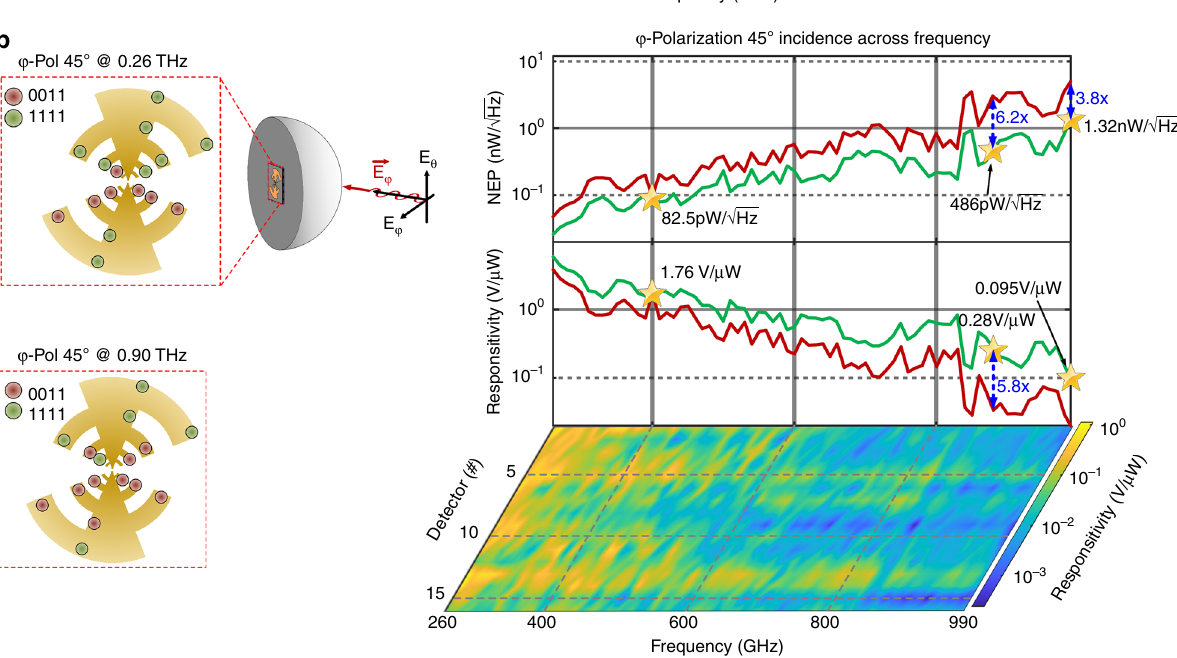
Fig. 7 Measurement results for optimized responsivity and corresponding NEP across 0.1 – 1.0 THz for two incidence angles at a 0° and b 45°, and two polarizations ( E θ and E φ ). The fi gure shows 8.9 and 4.5 times reduction in NEP at 0.86 THz and at 0.99 THz for broadside incidence and 6.2 times reduction in NEP for 45° incidence at 0.87 THz. The green line represents the sensor performance as it is optimized for each incident frequency. The red line represents the performance across frequency for a fi xed optimal con fi guration at 0.4 THz. The 2D color plots represent the contribution of power incident absorbed across the detector array across the optimized states between 0.1-1.0 THz. The fi gure also shows four examples of optimized states for the incident fi eld impinging at two angles of incidence at 0.26 THz and 0.9